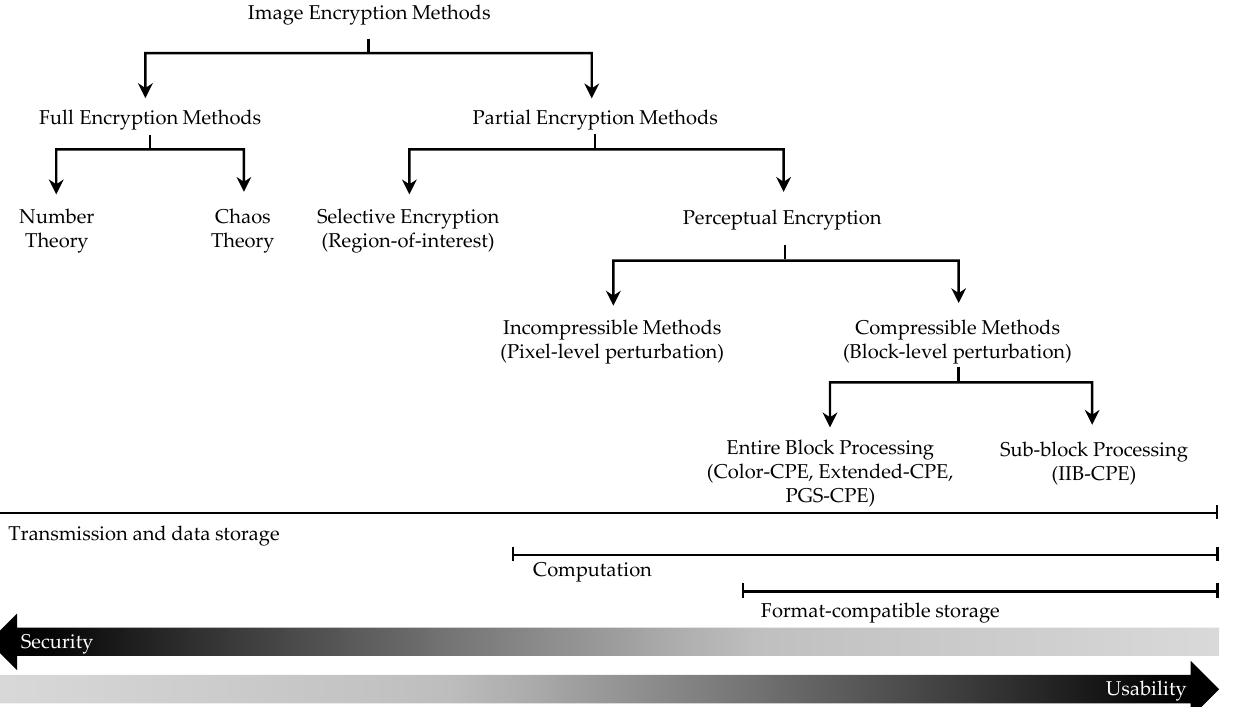
Figure 1. A taxonomy of image encryption methods based on their levels of security. From left to right, the encryption algorithms computational complexity decreases and security is traded for usability, i.e., to enable other multimedia applications such as format compliant storage and even processing the encryption domain.